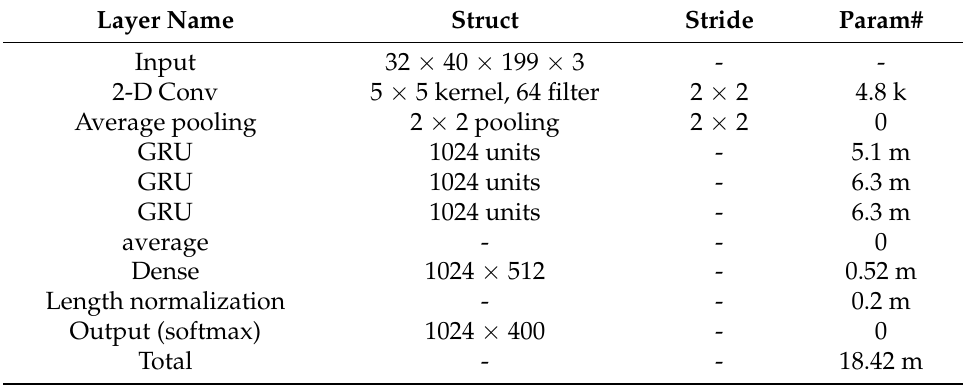
Table 6. The details on the deep GRU network